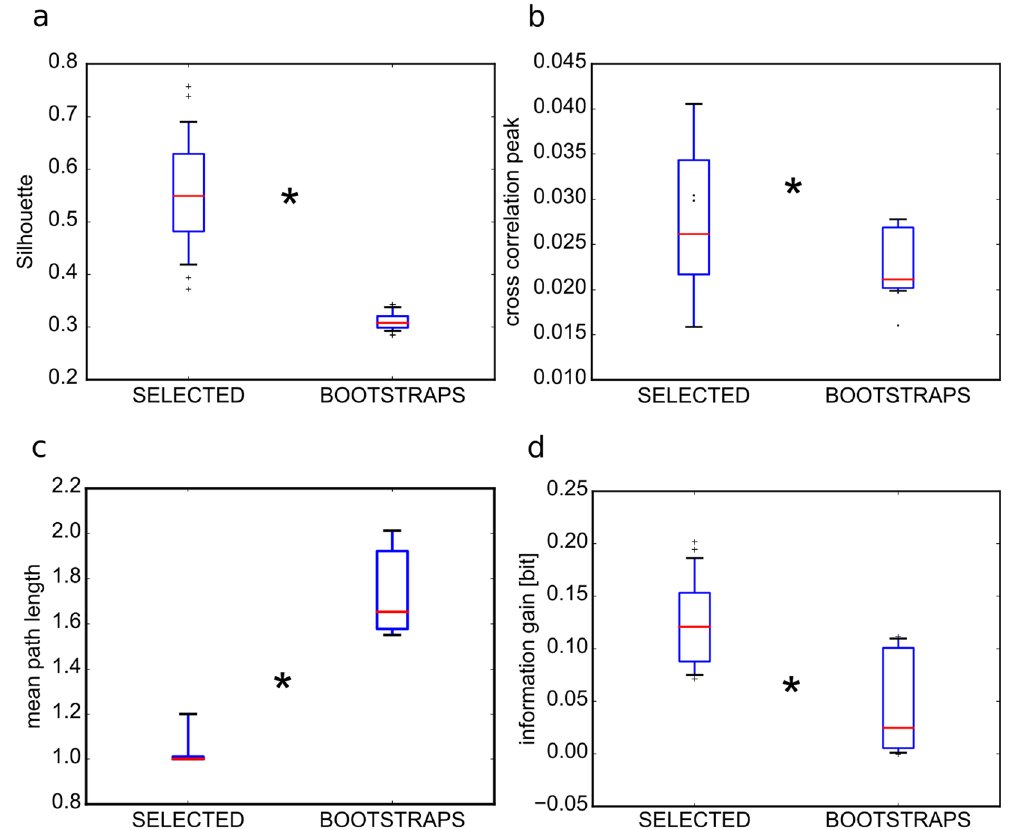
Figure 8. Spatial structure of electrodes selected by thresholding PCs. In all panels the electrodes are selected with PC weights higher than 3 SDs (SELECTED). All measures on SELECTED are compared to measures on equally sized sets randomly chosen from the complementary set of the non selected electrodes (n = 100 repetitions) and the 95 th values of those bootstraps are reported (BOOTSTRAPS). All box-plots are relative to the pooling of 10 PCs and 3 experiments. Red horizontal lines are means computed across 3 experiments, boxes show the interquartile range and the whiskers correspond to the 5 th and 95 th percentiles. ( a ) The silhouette coefficients, a measure of goodness of spatial clustering, are significantly higher when computed on the SELECTED electrodes respect to the BOOTSTRAPS (Wilcoxon signed-rank test, n = 30, p = 10 − 5 ). ( b ) The mean peak cross-correlation coefficients are significantly higher among the SELECTED electrodes respect to the BOOTSTRAPS (Wilcoxon signed-rank test, n = 30, p = 10 − 6 ). ( c ) Similarly, the mean path length is shorter among the SELECTED electrodes respect to the BOOTSTRAPS (Wilcoxon signed-rank test, n = 30, p = 0.001). ( d ) Finally, the information gain, computed over the [0 100] ms time window, is higher in the SELECTED electrodes respect to the BOOTSTRAPS (Wilcoxon signed-rank test, n = 30, p = 10 − 6